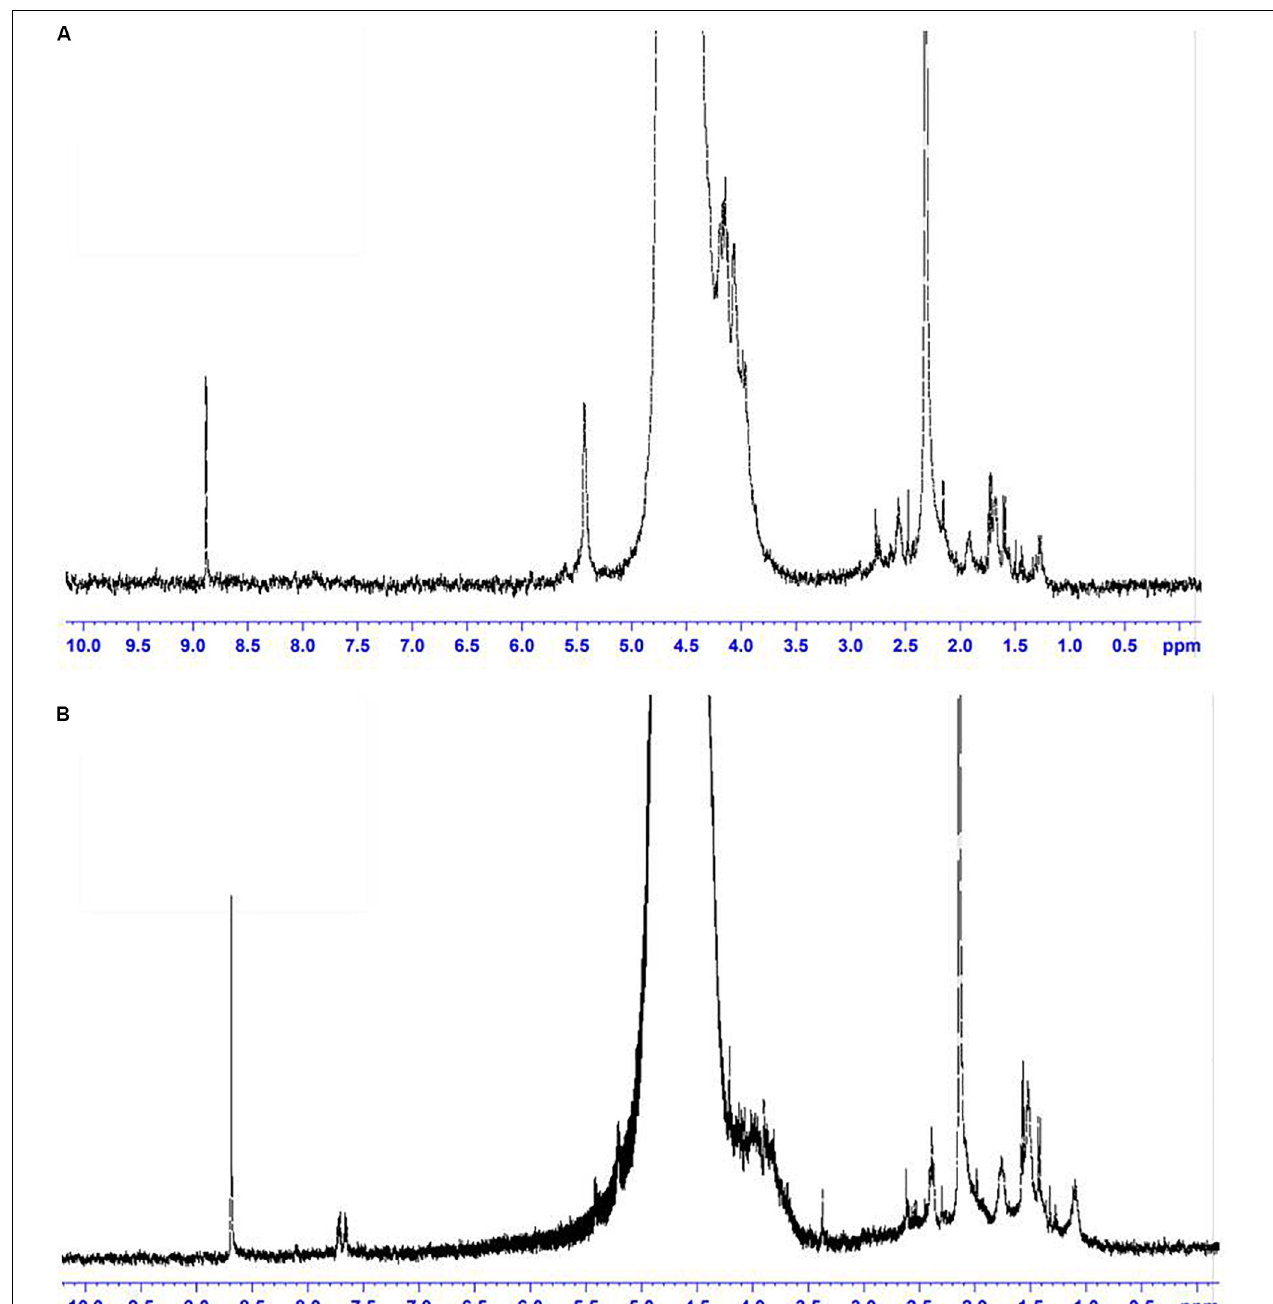
FIGURE 7 | NMR spectra: (A) oligosaccharide produced by L. ferriphilum CC, (B) exopolysaccharide produced by At. ferrooxidans Ksh.